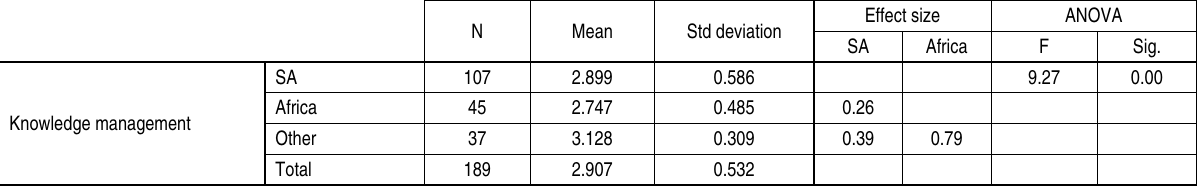
Table 5. Descriptive statistics and ANOVA results for the geographic location